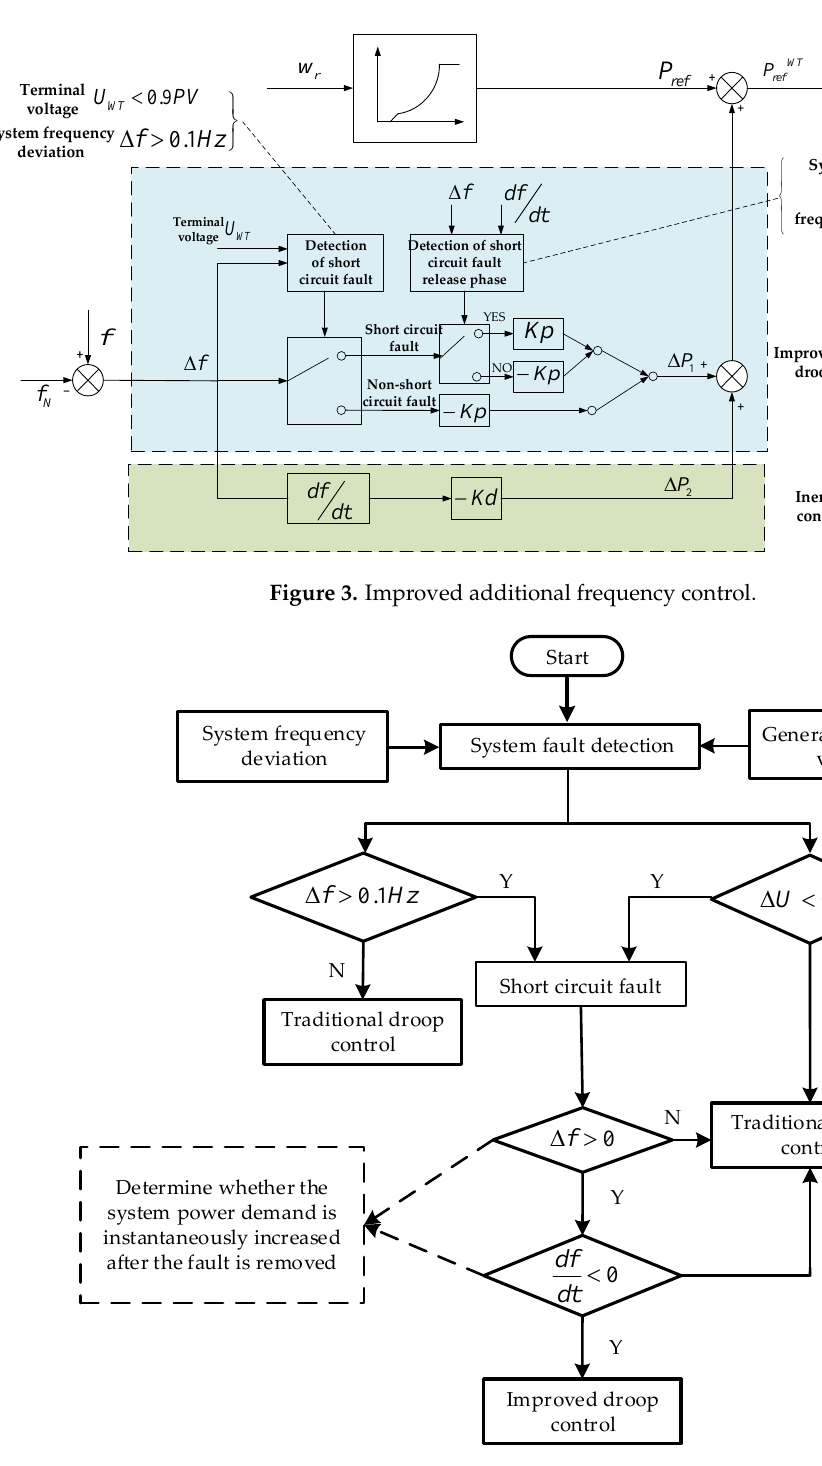
Figure 4. Implementation process of improved additional frequency control algorithm.